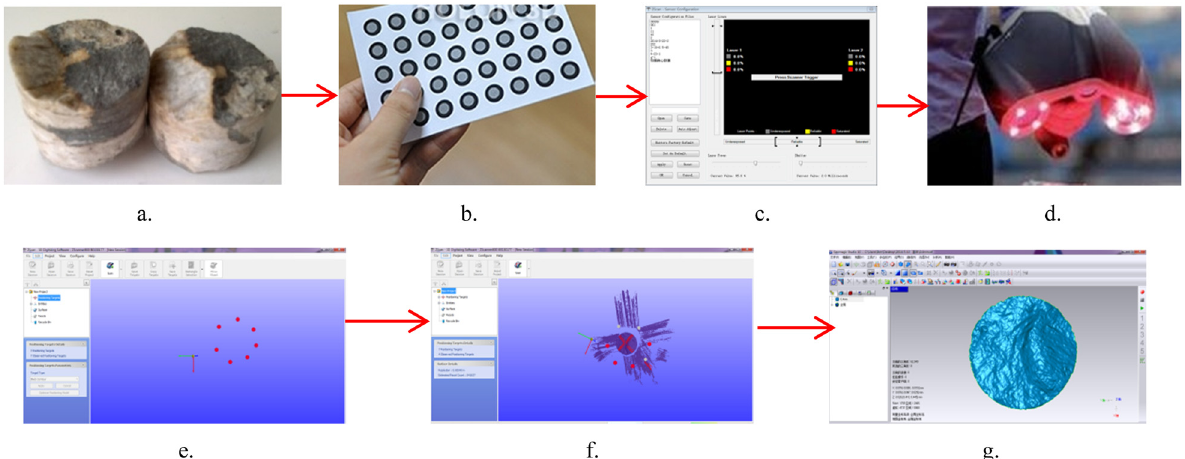
Figure 4: 3D laser scanning process. ( a ) Scanning specimen preparation. ( b ) Paste the sensitive plate. ( c ) Debug scanner. ( d ) Prescan. ( e ) Scan sensitive plate. ( f ) Scan structural plane. ( g ) Data